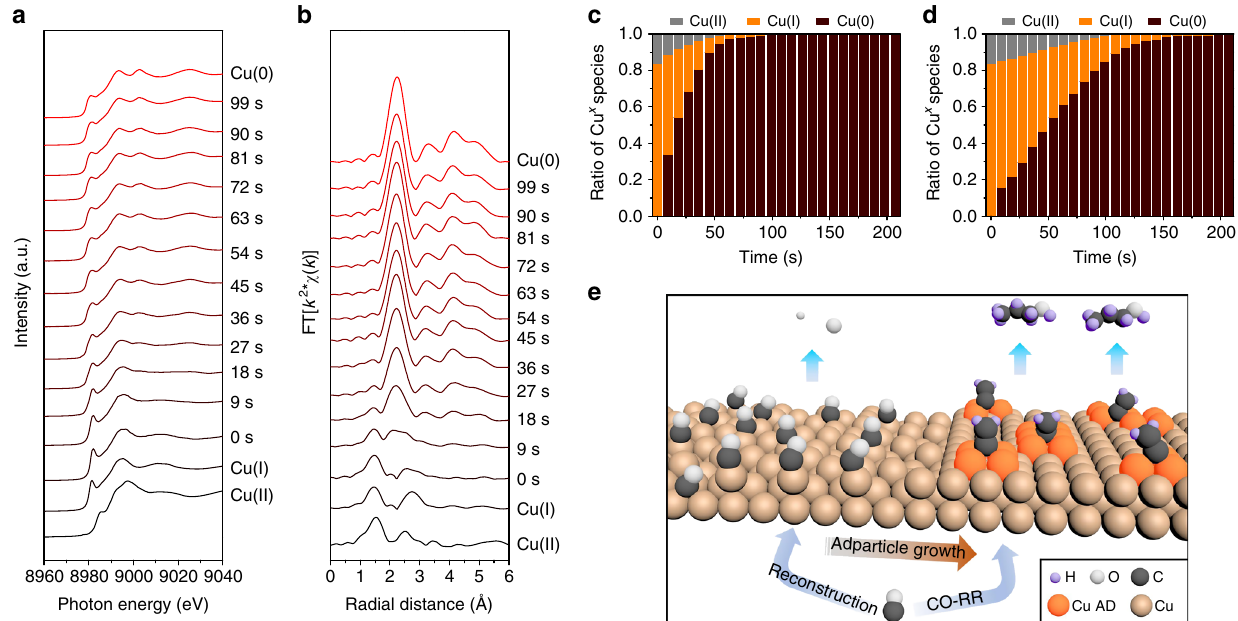
Fig. 3 Operando Cu K-edge hXAS analysis. a Operando Cu K-edge hXAS for tracking the growth of Cu adparticles under CO-RR at − 0.44 V vs. RHE in 1 M KOH. Cu K-edge hXAS of copper(II) oxide, copper(I) oxide and metallic Cu standards measured ex-situ are included for comparison. b Fourier transform of spectra in a . c , d Calculated ratio of Cu oxidation states over the course of oxide reduction at − 0.44 V vs. RHE in 1 M KOH under CO and He gas condition, respectively, obtained by performing linear combination fi tting of their corresponding Cu K-edge hXAS. e Schematic illustration of in-situ Cu adparticle (AD) growth mediated by CO chemisorption/reaction on defective Cu surface and the formation of n-propanol on adparticles